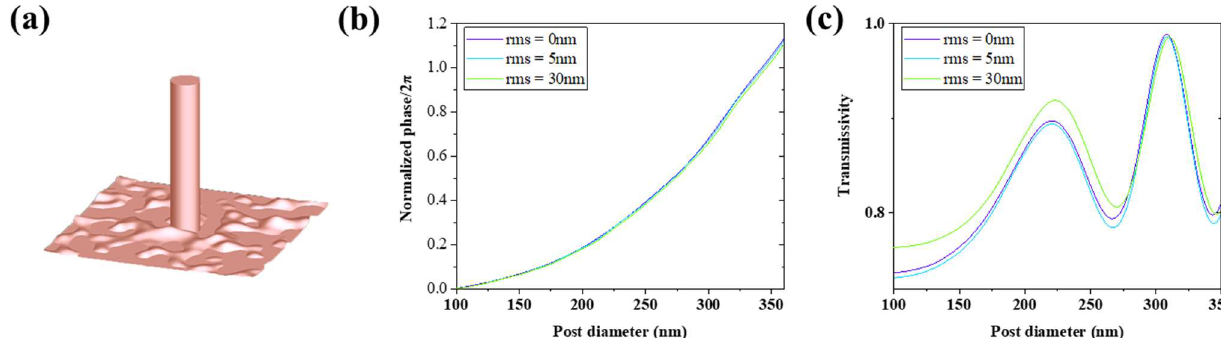
Figure 3. ( a ) One of the models of unit structures with rough surface (rms = 30 nm) in trenches established in software. ( b , c ) Simulation results of units with different surface roughness in